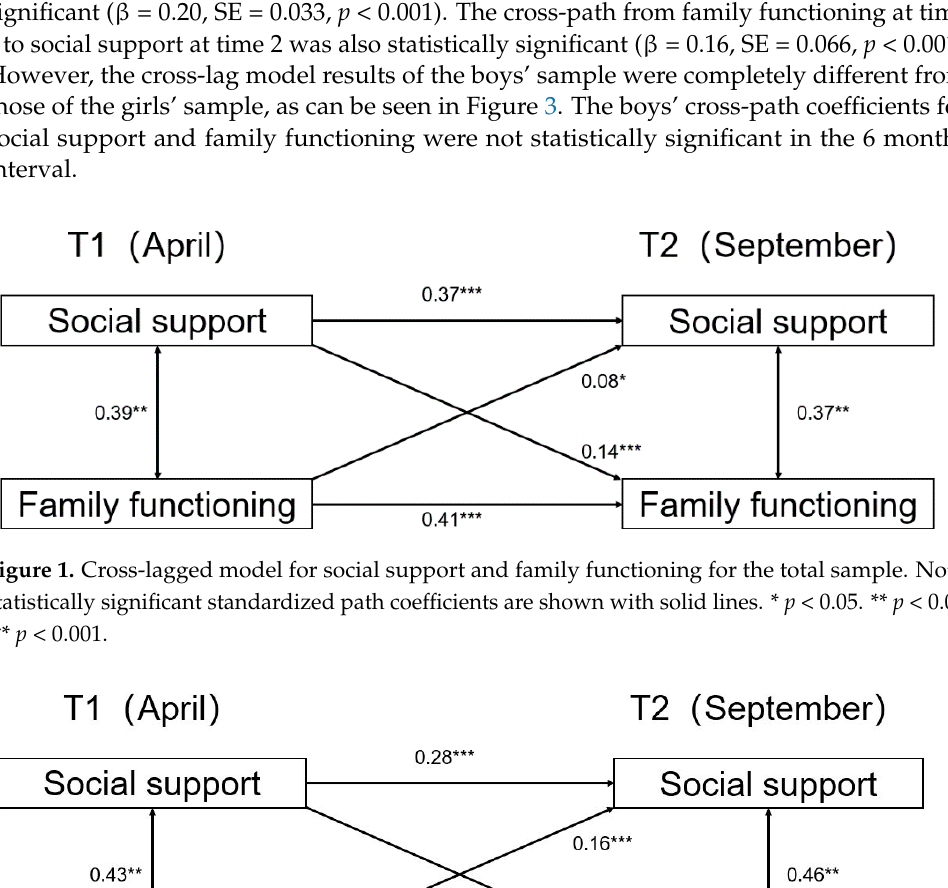
5.01 Note. For sex, 1 = boys, 2 = girls. T1 = time 1; T2 = time 2 (approximately 6 months after time 1). * p < 0.05. ** p < 0.01. 3.2. Cross-Lagged Model of Social Support and Family Functioning In the present study, we constructed a manifest variable cross-lagged model to ex-